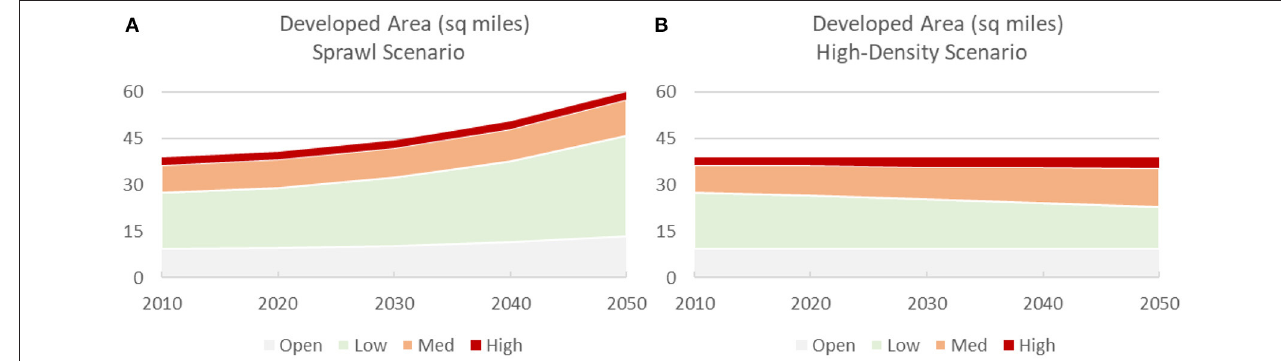
FIGURE 1 | Estimation of population density (in sq. miles) for each developed area under high-density development. (A) Developed area (sq miles) sprawl scenario. (B) Developed area (sq miles) high-density